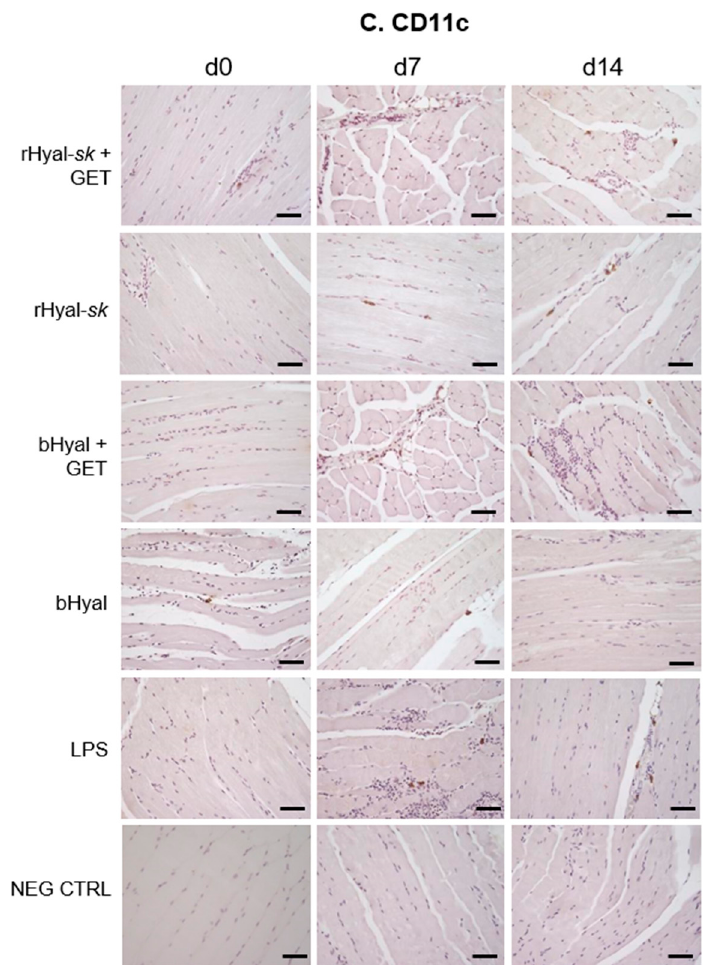
Figure 3. Immunochemistry of muscles treated with rHyal- sk in the presence and absence of GET. Skeletal muscle FFPE sections were stained at 3h (d0), d7 and d14 after treatment with monoclonal antibodies specific for macrophages ( A , F4/80) and dendritic cells ( B , MHC-II; C , CD11c). Positive control samples were muscles treated with LPS. Negative control samples included skeletal muscle harvested from untreated mice. All sections were counterstained with hematoxylin and analysed by optical microscopy. 20 × magnification. Scale bars, 50 µ m. rHyal- sk , recombinant Hyal from Fidia Farmaceutici; bHyal, bovine Hyal from Sigma-Aldrich; Hyal + GET, electrotransfer after Hyal injection; LPS, lipopolysaccharide injection; NEG CTRL, untreated muscle.